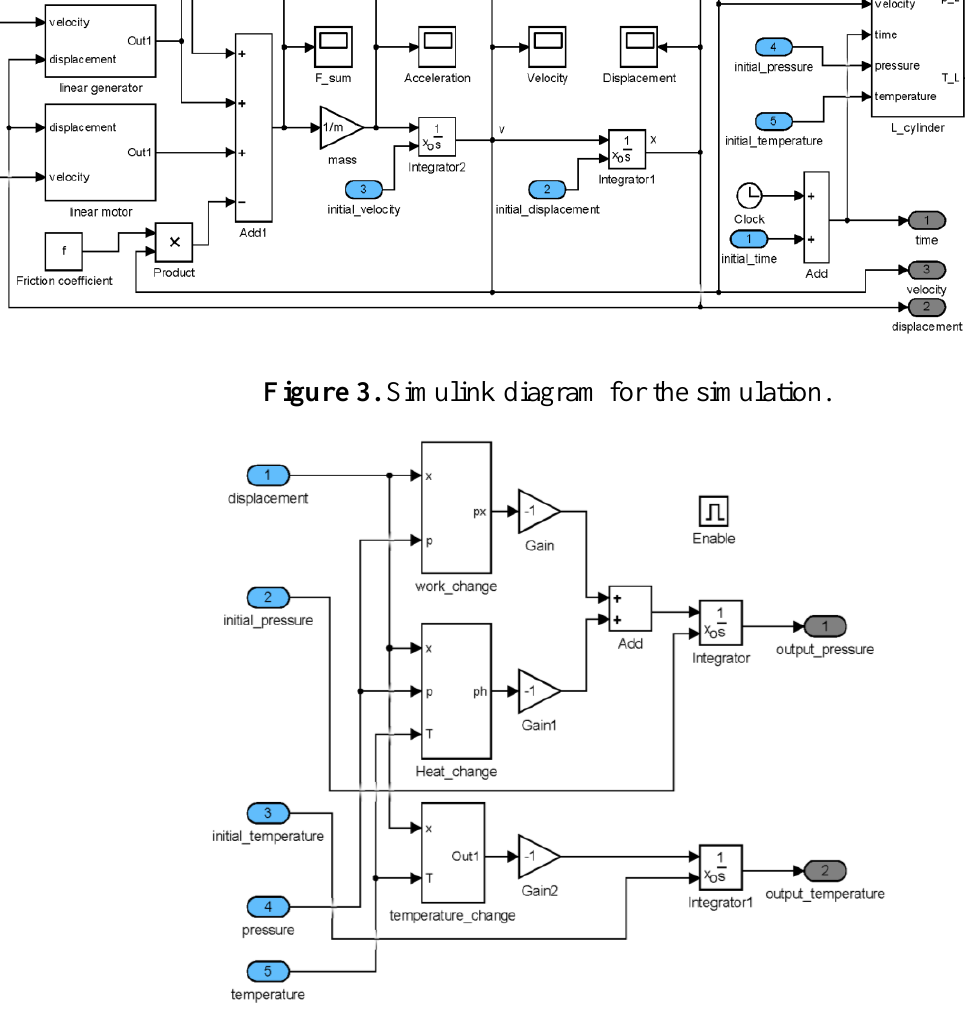
Figure 4. Block diagram of the “engine”